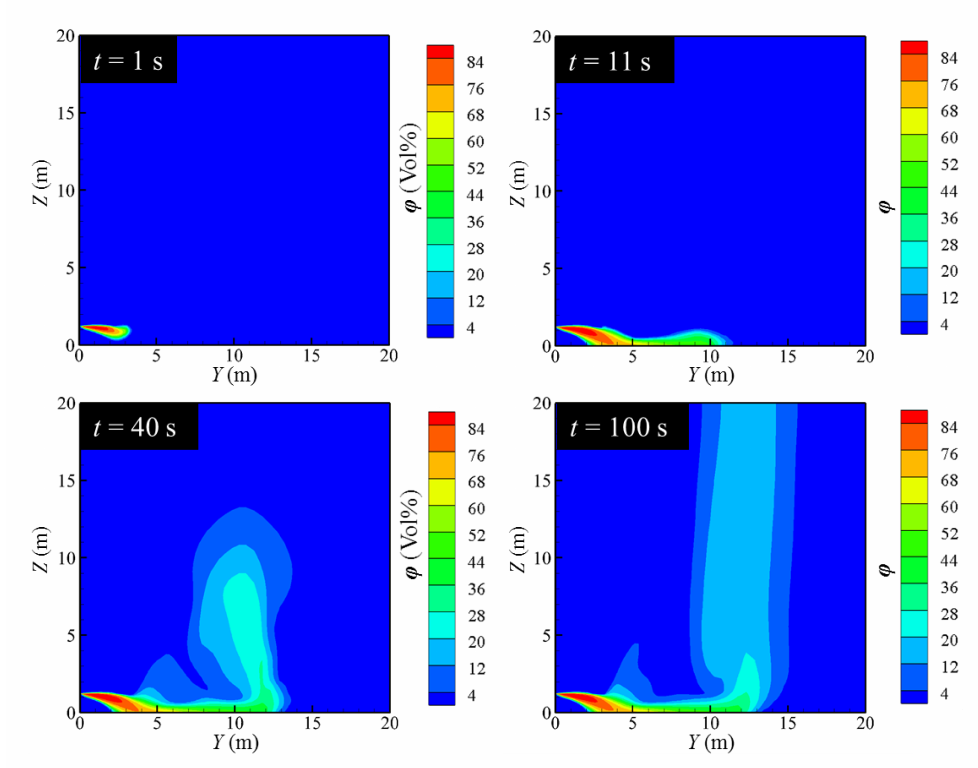
Figure 6. Variation of hydrogen concentration